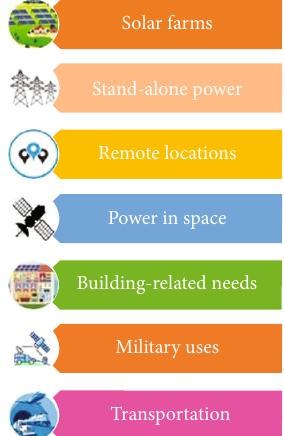
Figure 2: Photovoltaic